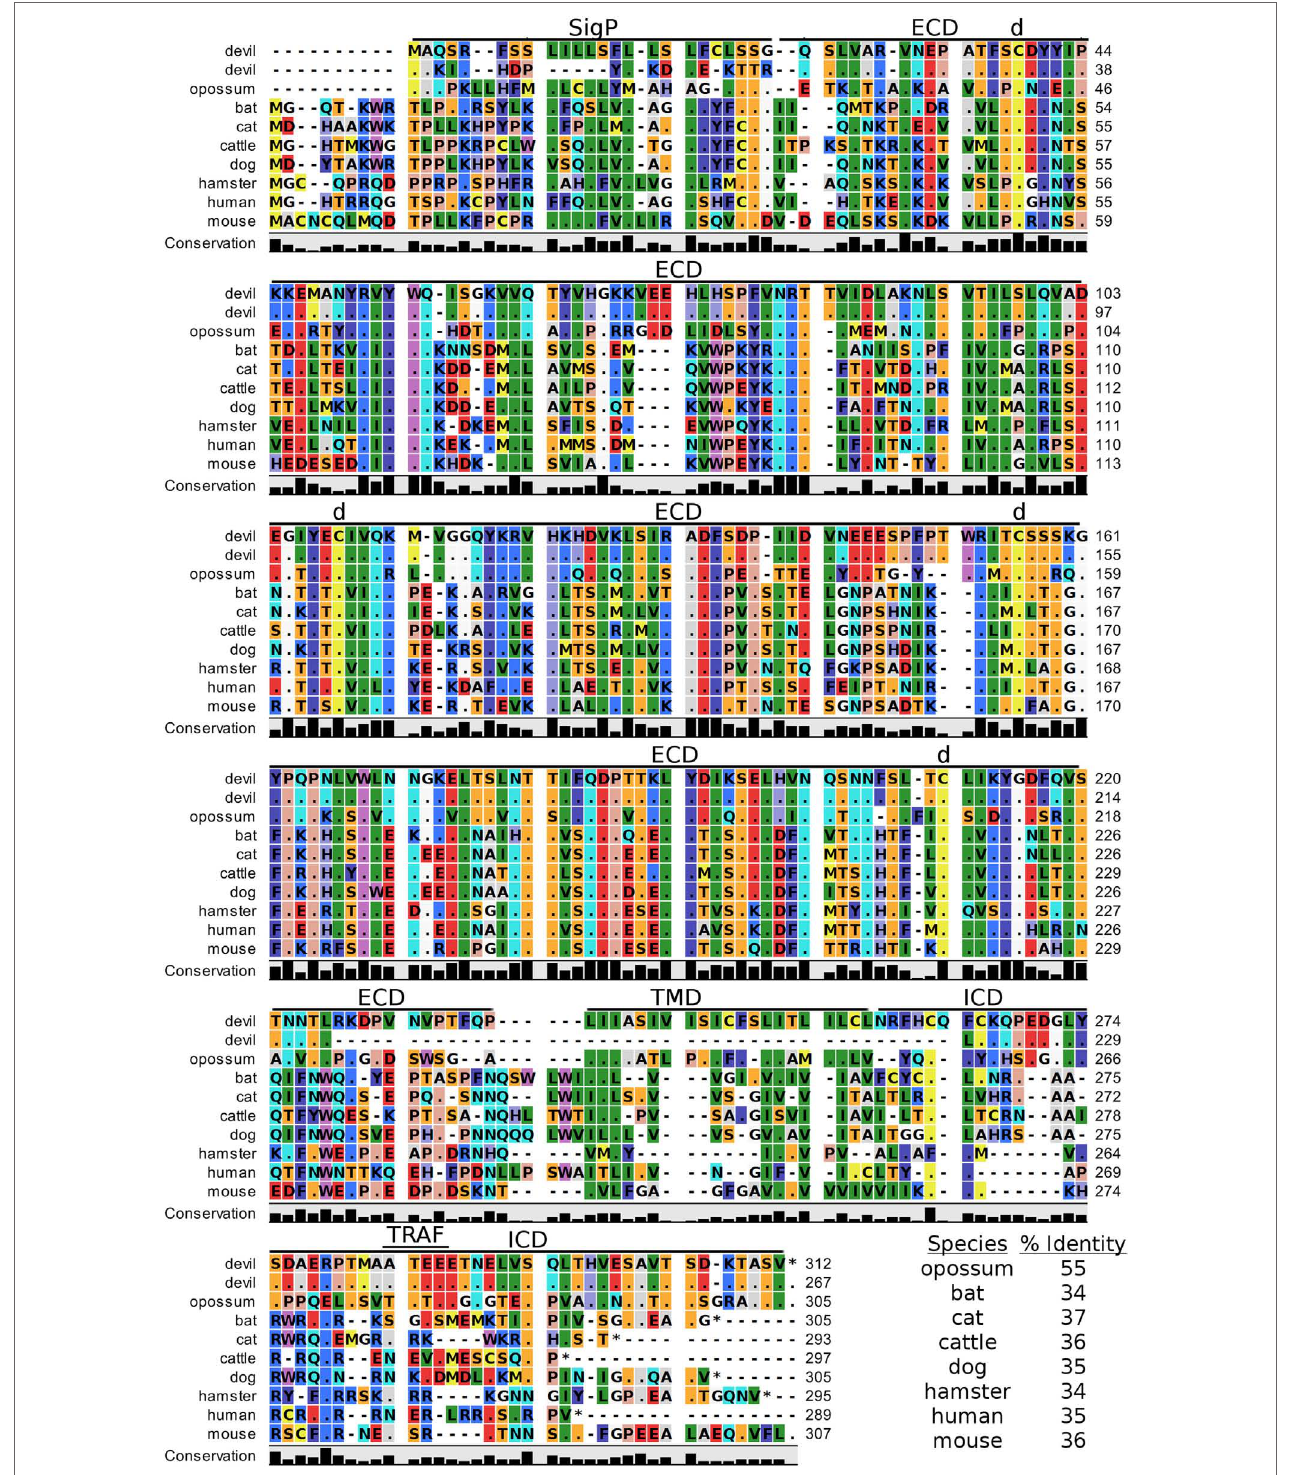
FigUre 4 | alignment of cD80 reference genes for nine species . The predicted signal peptides (SigP), extracellular domain (ECD), transmembrane domain (TMD), and intracellular domain (ICD) are demarcated with bars. The uppermost devil CD80 sequence is the full-length sequence and the lower devil CD80 is the potential secreted CD80 sequence. “d” above the alignment represents predicted disulfide bonds. TRAF indicates a putative TRAF1/2-binding site. The black bar graphs below the alignment represent the conservation of amino acids across all nine species. The percent amino acid sequence identity between devils and other species is shown in the bottom right corner of the